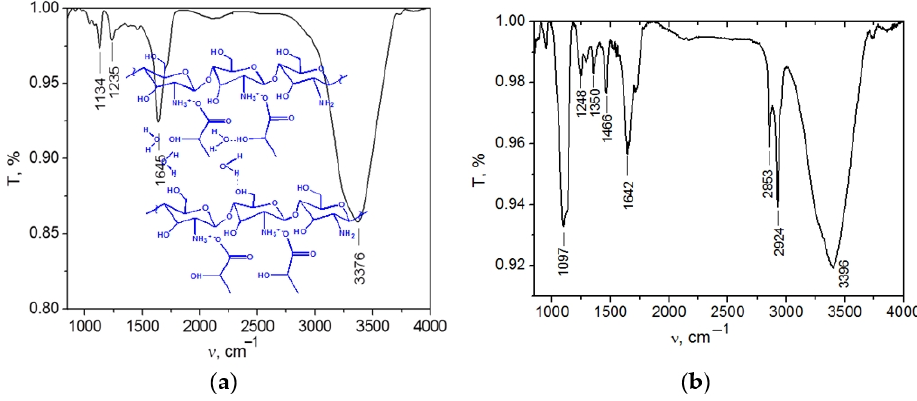
Figure 3. FTIR spectra of Chit/LA 5/95 wt. % ( a ); C 12 EO 4 /(Chit:LA) 50/50 wt. % ( b